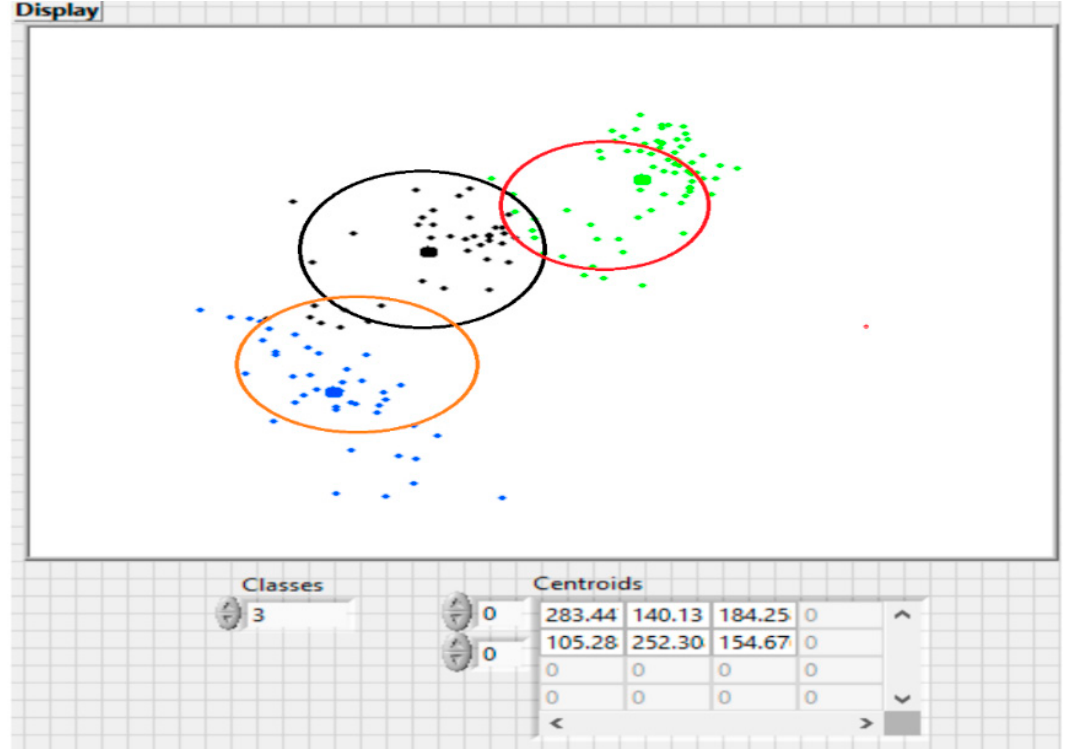
Figure 21. Detecting RSSI by classes using the proposed algorithm (red—2 meters; blue—12 meters; green—6 meters).